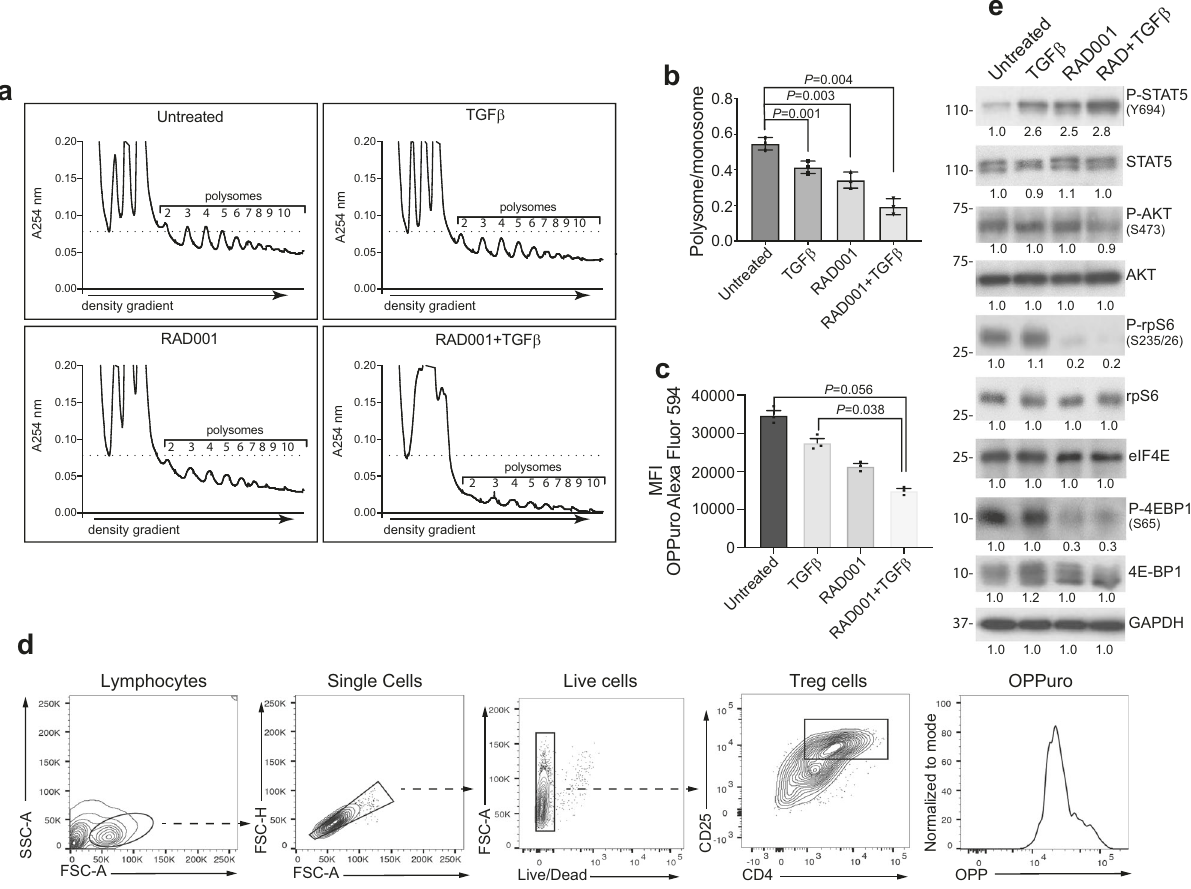
Fig. 4 mTORC1 blockade strongly reduces protein synthesis and mTORC1 signaling activity. a RAD001 + TGF-beta-treated CD4 + Treg cells have strongly reduced polysomes in number and ribosome mRNA content, indicative of both low rates of ribosome loading and impaired protein synthesis. Translating ribosomes associated with mRNAs (polysomes) were extracted from untreated, TGF-beta-treated, RAD001-treated, and RAD001 + TGF-beta- treated CD4 + T cells obtained from one donor per study, and resolved by sucrose density gradient centrifugation with continuous monitoring of RNA absorbance at 254 nm. From left to right, peaks correspond to the bulk of non-ribosomal RNA, 40 S ribosomal subunit, 60 S ribosomal subunit, 80 S ribosomes (monosomes), and polysomes (labeled). The number of ribosomes in polysomes is indicated. Polysome analysis was conducted three times from three donors. b Quanti fi cation of polysome levels in a during treatment from three donors. Areas under the curve (AUC) for monosomes and polysomes were calculated, presented as ratio of polysome to monosome integrals, with the ratio for untreated samples set at 1. P values determined using Fisher ’ s exact test with means and SEM shown. c Untreated and RAD001 + TGF-beta differentiated CD4 + Treg cells at 12 d post-differentiation from three donors were labeled by puromycylation using Click-iT Plus OPP and quanti fi ed by fl ow cytometry for Alexa Fluor 488 incorporation into protein for synthesis rates. Data are normalized with untreated control group mean fl uorescent intensity (MFI). P values determined by one-way ANOVA test with Dunnett post-ANOVA test determination, with mean values and SEM shown. d Gating strategy for OPP-quanti fi ed protein synthesis rate analysis by fl ow cytometry within the Treg cell compartment. Representative of three independent studies from three donors. e mTORC1 pathway is downregulated in RAD001 + TGF-beta-treated cells, whereas STAT5 phosphorylation is increased. Untreated and treated CD4 + T cells from four pooled donors were used for normalized representation, as described in Fig. 2 legend. Cell lysates were obtained and equal protein amounts were analyzed by immunoblot. Quanti fi cation of individual bands by digital pixel intensity is shown below each blot, normalized to untreated CD4 + T cells. STAT5 is a marker for induced Treg cells. A study with pooled specimens from two donors was independently performed twice with similar results. Source data are provided as a Source Data fi mRNAs that demonstrated eIF4E/mTORC1-independent trans- lation, regulation of differentiation by WNT, Sonic Hedgehog signaling and homeotic gene expression pathways (PRICKLE1, PTCHD1, SCML1, respectively) were the top representative functions, as well as gap junction protein regulators (GJB6).